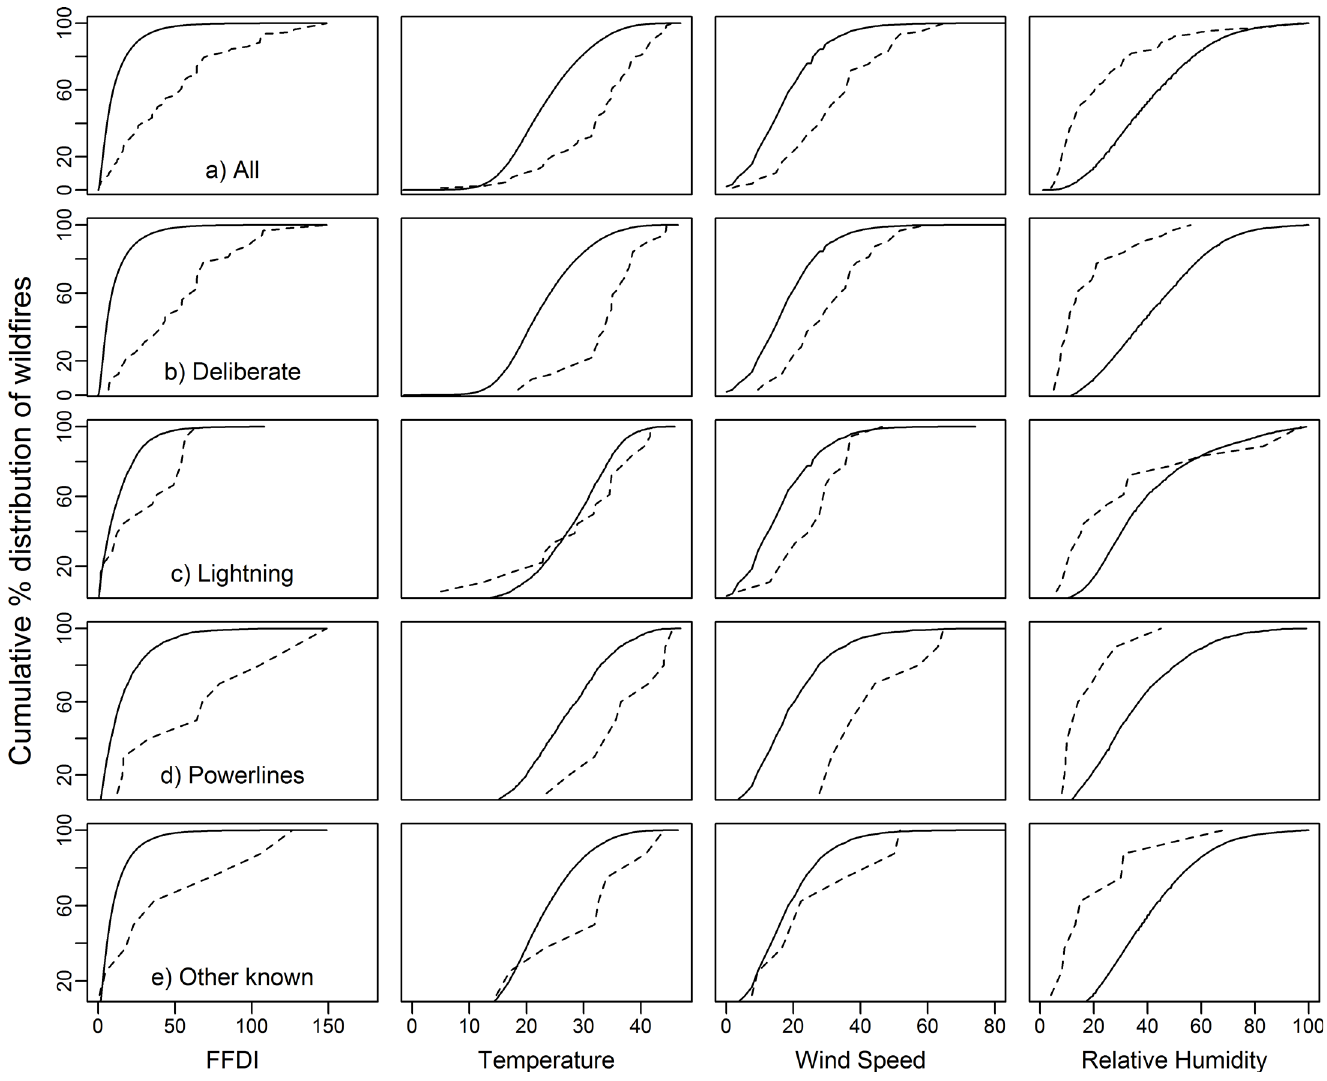
Fig 5. Cumulative % distribution of wildfires that destroyed houses and wildfires where no houses were destroyed by ignition cause for the 12 years with complementary data for fire weather elements. Forest Fire Danger Index (FFDI), dotted line = wildfires that destroyed houses, solid lines = wildfires where no houses were destroyed, All = all ignition causes including undetermined